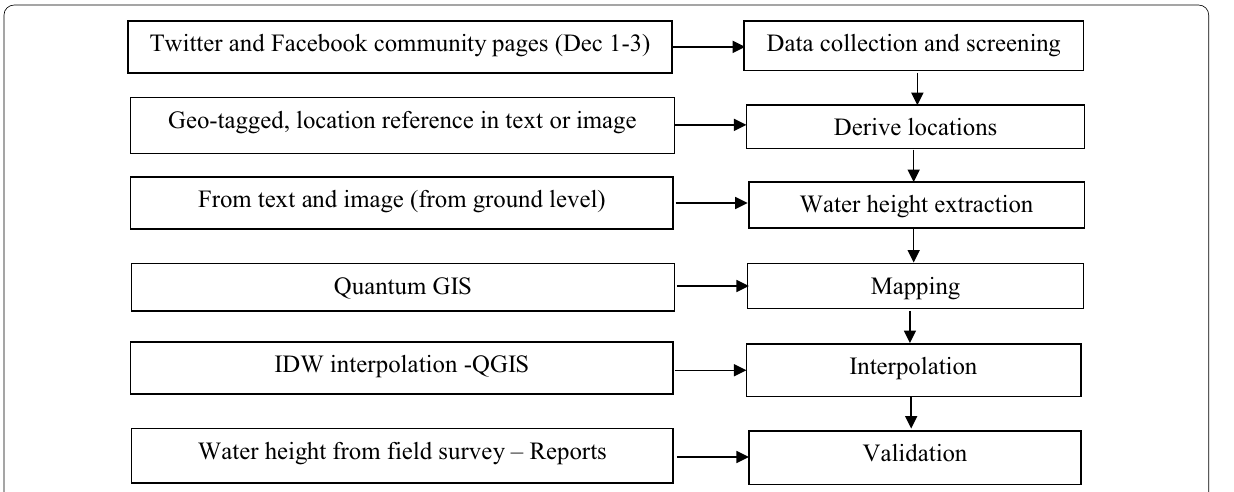
Fig. 2 Framework of water extent mapping from social media